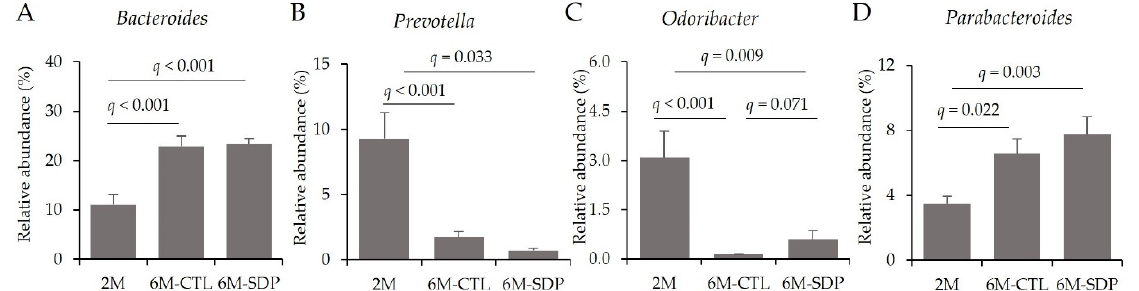
Figure 10. Fecal microbial composition at the genus level of the Bacteroidetes phylum. Relative abundance of Bacteroides ( A ), Prevotella ( B ) Odoribacter ( C ), and Parabacteroides ( D ). Results are expressed as mean ± SEM ( n = 10–11 mice/group). Statistics: ANOVA (False discovery rate, Benjamini and Hochberg multiple comparison test).